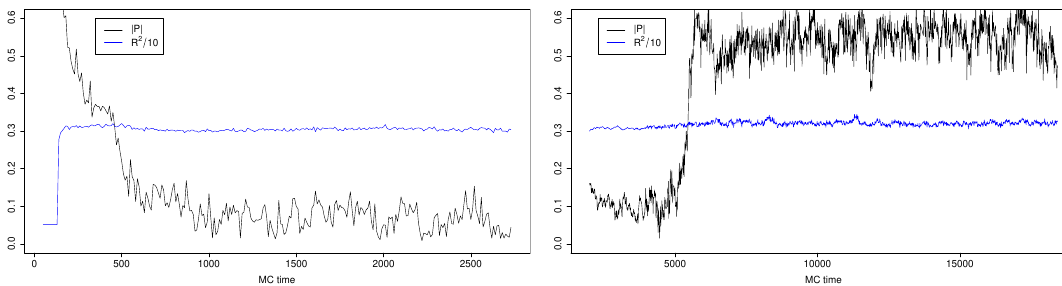
Figure 25. Full BMN model: [Left] Monte Carlo history for N = 16 , L = 24 , µ = 0 . 6 , T = 0 . 22 . The confined phase ( | P | ’ 0 ) is observed. [Right] For N = 16 , L = 24 , µ = 0 . 6 , T = 0 . 29 , starting with a confined configuration. A transition to the deconfined phase is observed. The temperature window is of order ∆ T ≈ 0 . 07 at these